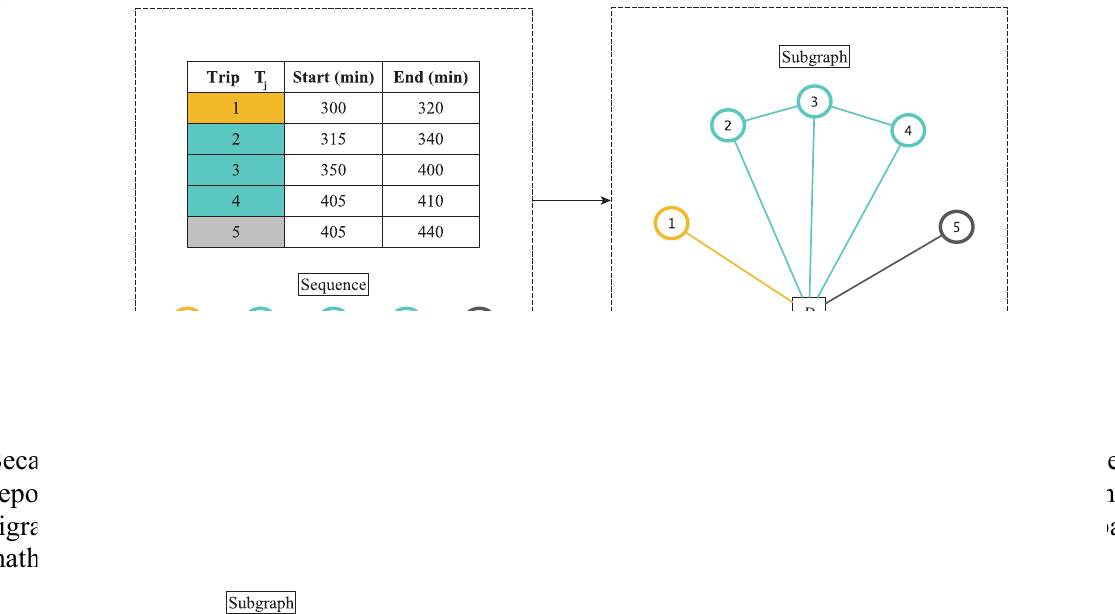
Fig. 9. Subgraph (or auxiliary graph) after removing infeasibilities